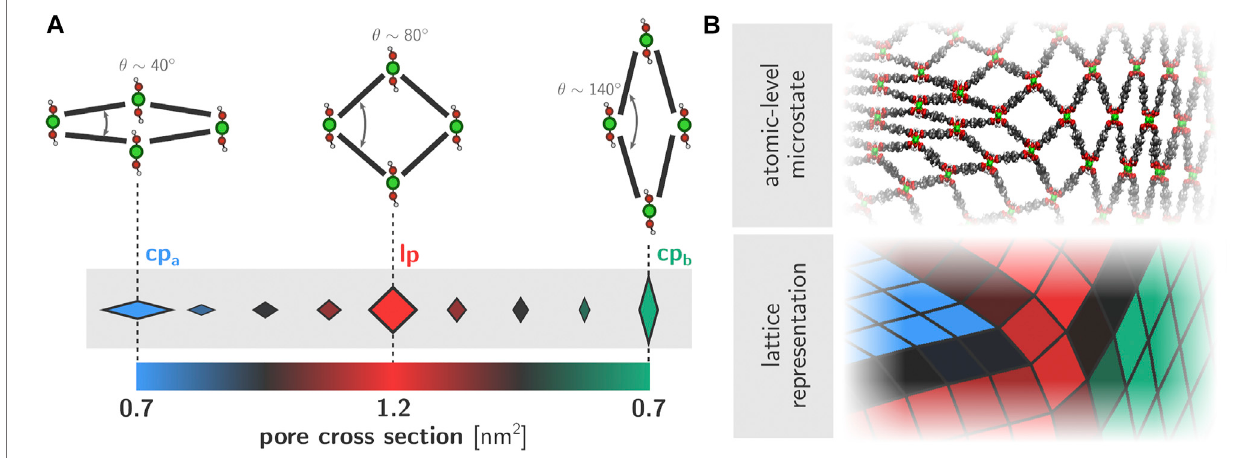
FIGURE 3 | (A) Quadrilateral representation of individual one-dimensional channels within the wine rack topology of MIL-53(Al). The color of each quadrilateral is determined based on the instantaneous cross-sectional area of the corresponding channel (B) Example con fi guration of the framework and corresponding two- dimensional lattice